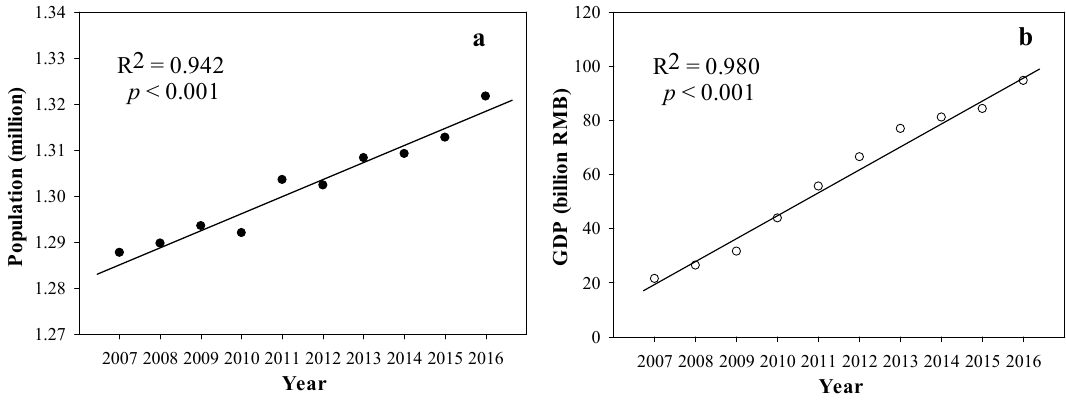
Figure 7. The increase in ( a ) population and ( b ) GDP in the Lake Liangzi basin from 2007 to 2016.